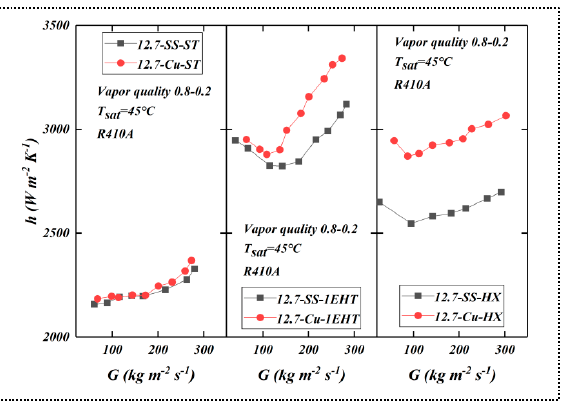
Figure 8. Comparison of HTC (as a function of mass flow rate) for tubes of the same diameter (12.7 mm) produced of different materials for smooth (ST) and enhanced (1EHT and HX) tubes.